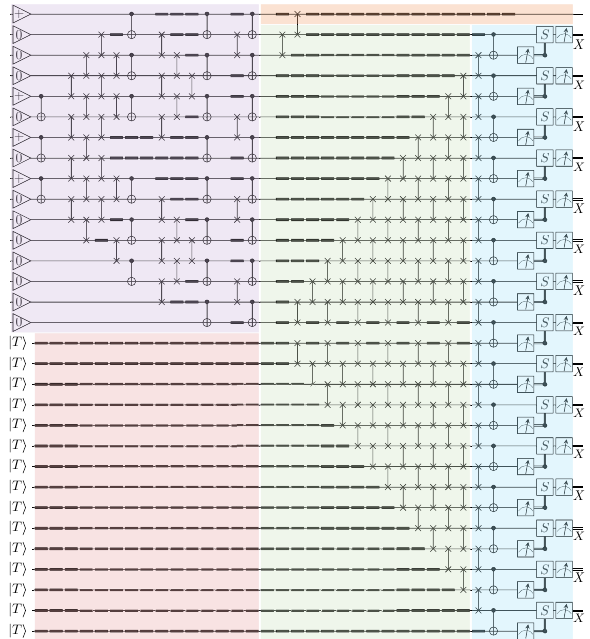
FIG. 22. The 15-to-1 state distillation protocol implemented on the logical level using nearest-neighbor operations in a stack of 2D color codes. The 31 logical qubits are encoded in distance- d 2D color codes, which are stacked on top of one